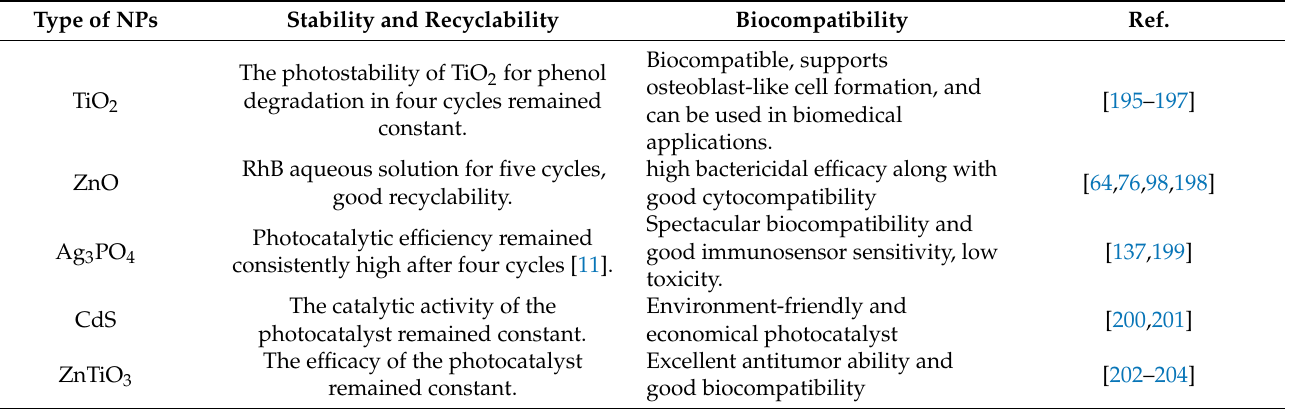
Table 8. Photocatalytic Stability and biocompatibility of different NP